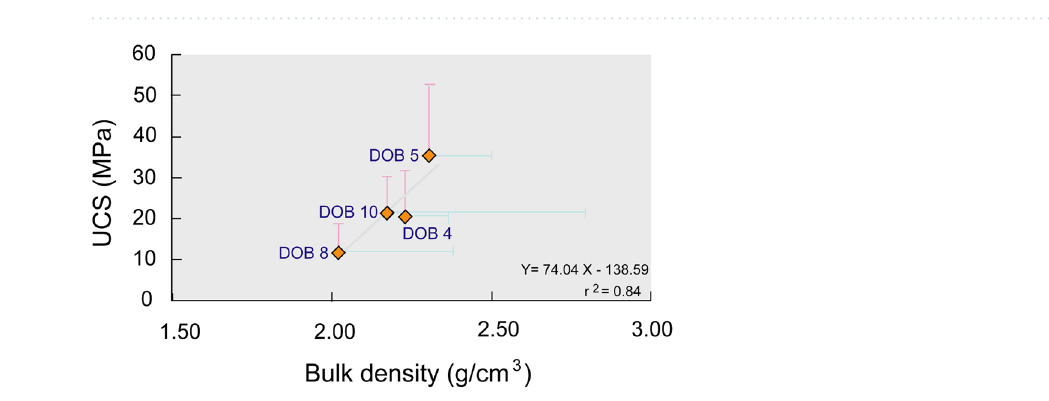
Figure 4. The faults (red) and a dyke (cyan) of the Barapukuria coal basin and the mining panels (BCMCL 21 ).